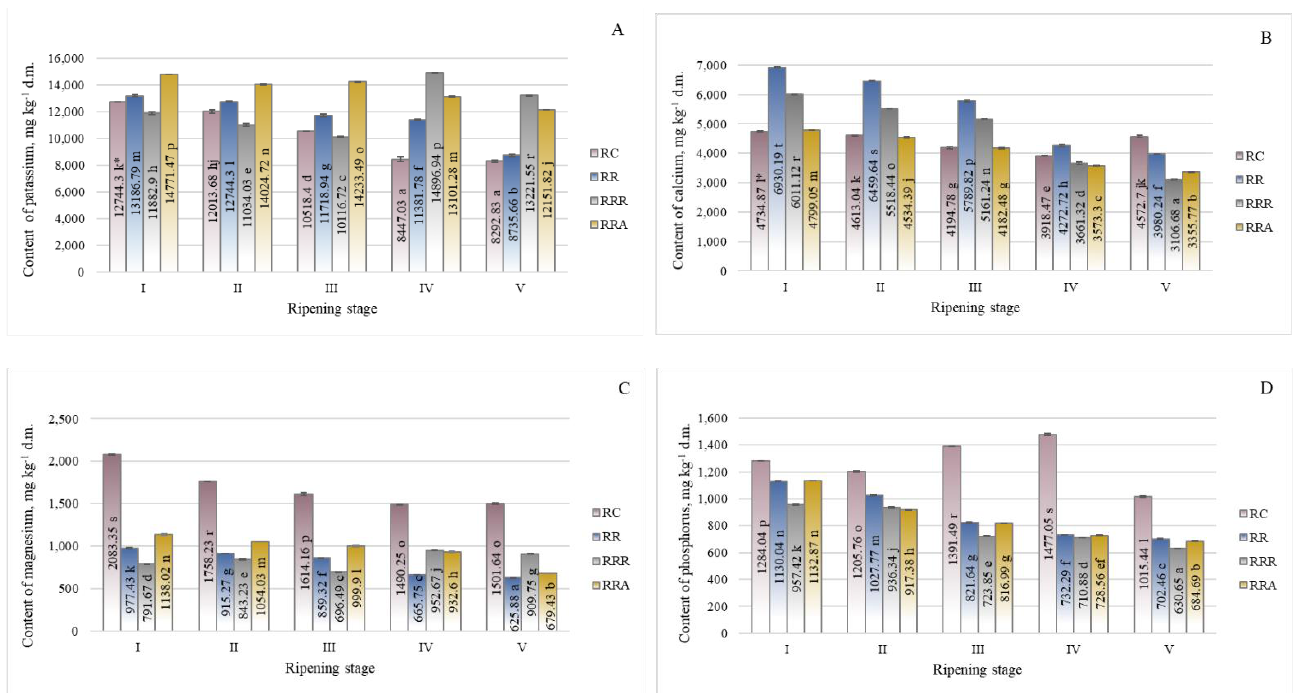
same letter) are significant at p ≤ 0.05. RC — Rosa canina , RR — Rosa rugos a, RRR — Rosa rugosa ‘Rubra’, RRA— Rosa rugosa ‘Alba’. Figure 2. The effect of ripening stages on the content of macro element (mg kg −1 d.m.) ( A ) — potassium, ( B ) — calcium, ( C ) — magnesium, ( D ) — phosphorus of rosehip fruits (average for 2018 – 2020